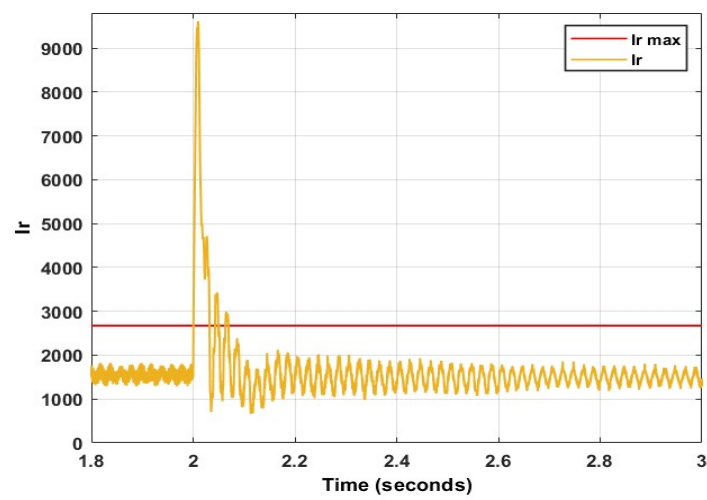
Figure 17. Rotor current transient using PSO at 90% dip.